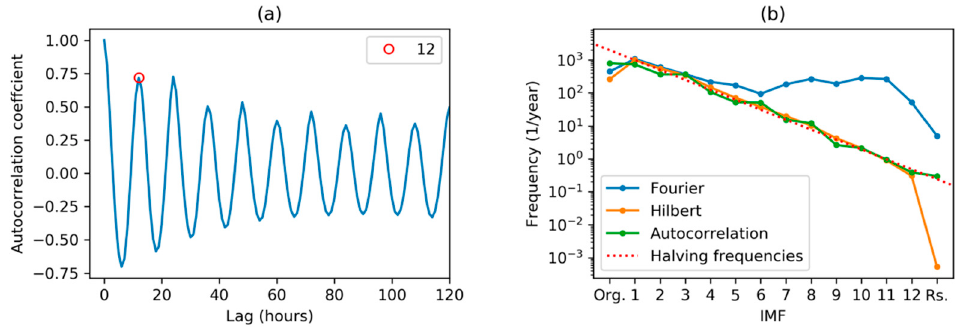
Figure 17. Electricity demand autocorrelation: ( a ) Values corresponding to the first IMF; ( b ) dominant frequencies for each IMF and their comparison to DFT and MHT spectral centroids.